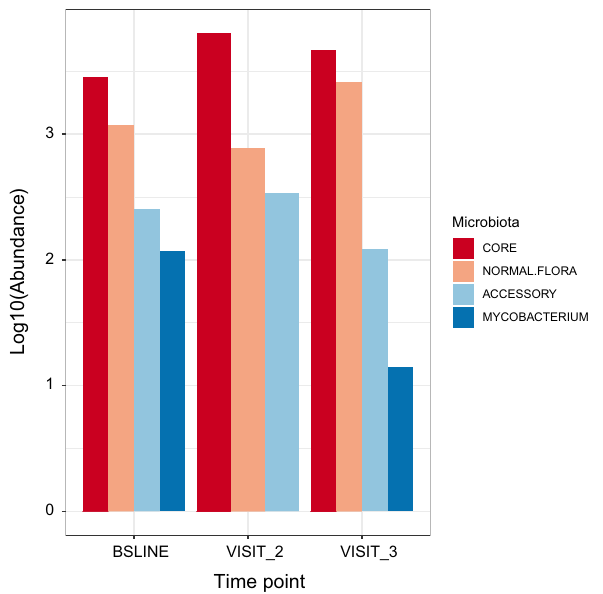
Figure 6. Changes in microbial components i.e., core and accessory microbiota; oral disease associated microbiota and Mycobacterium . This figure is based database C of Fig. 1.